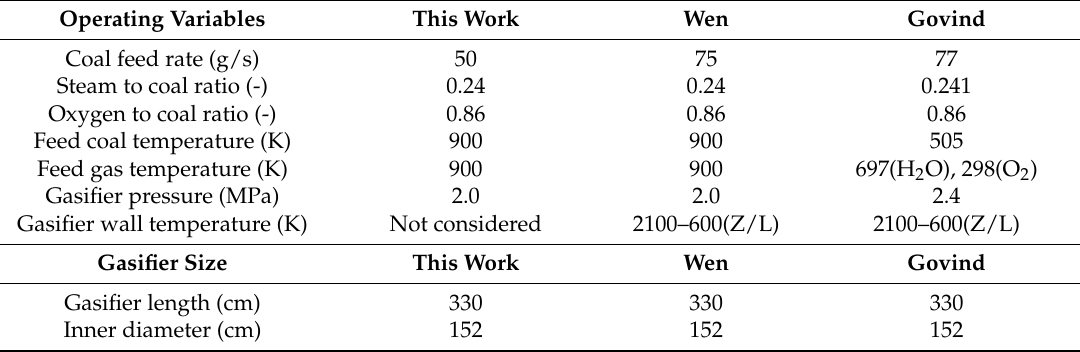
Table 4. Comparison of operating variables and gasifier size between this and previous studies.